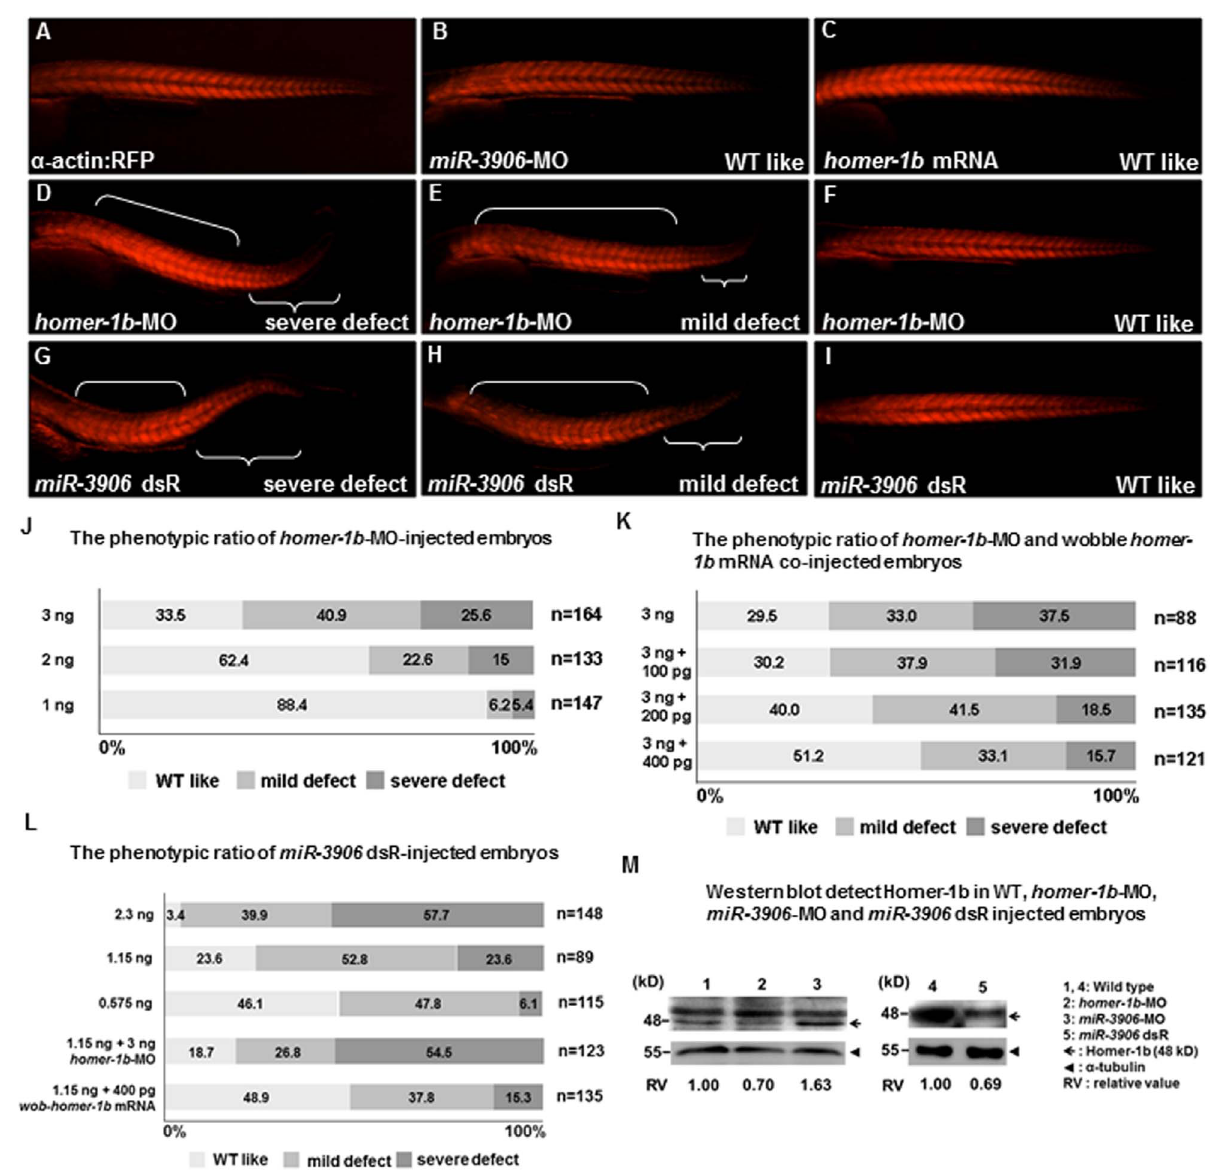
Figure 4. Defective phenotypes induced by injection of excessive miR-3906 and homer-1b -MO were similar. ( A – I ) Embryos derived from transgenic line Tg ( a -actin:RFP), in which red fluorescence protein (RFP) is expressed specifically in skeletal muscles, were injected with miR-3906 -MO, miR-3906 dsR (mature double- strand miR-3906 ), homer-1b -MO or homer-1b mRNA, as indicated. After injection, the development of trunk muscle was observed at 32 hpf. Compared with WT ( A ), the morphological trait of embryos injected with either miR-3906 -MO ( B ) or homer-1b mRNA ( C ) was similar to that of WT. Embryos injected with homer-1b -MO ( D – F ) and exogenous miR-3906 ( miR-3906 dsR) ( G – I ) displayed such defective phenotypes as body axis bending and trunk muscle shortening in tail. Based on the definition of three defective levels of muscle (see Materials and Methods), we calculated the defective percentages of embryos injected with homer-1b -MO alone ( J ) and homer-1b -MO plus wobble homer-1b mRNA ( K ). The occurrence percentages of severe and mild defects of embryos injected with 1.15 ng miR-3906 dsR alone, 1.15 ng miR-3906 dsR plus 3 ng homer-1b - MO and 1.15 ng miR-3906 dsR plus 400 pg homer-1b mRNA were calculated ( L ). n: indicates the total number of embryos after three injections. ( M ) Western blot analysis of Homer-1b (48 kD, arrow) in WT (lanes 1 and 4), 3 ng homer-1b -MO-injected embryos (lane 2), 8 ng miR-3906 -MO-injected embryos (lane 3) and 1.15 ng miR-3906 dsR-injected embryos (lane 5). Detection of a -tubulin served as internal control (arrowhead). The relative intensity of Homer-1b protein among WT, homer-1b -MO, miR-3906 -MO and miR-3906 dsR was also indicated. injected embryos (Fig. 4M, lane 3) and reduced in the miR-3906 dsR-injected embryos (Fig. 4M, lane 5), suggesting that miR-3906 regulates Homer-1b protein expression and impacts the muscle development of zebrafish embryos. Homer-1b is a scaffold protein, not a transcription factor, in mammals [38]. It has been reported that Homer-1b binds ryanodine receptor to regulate calcium release from sarcoplasmic